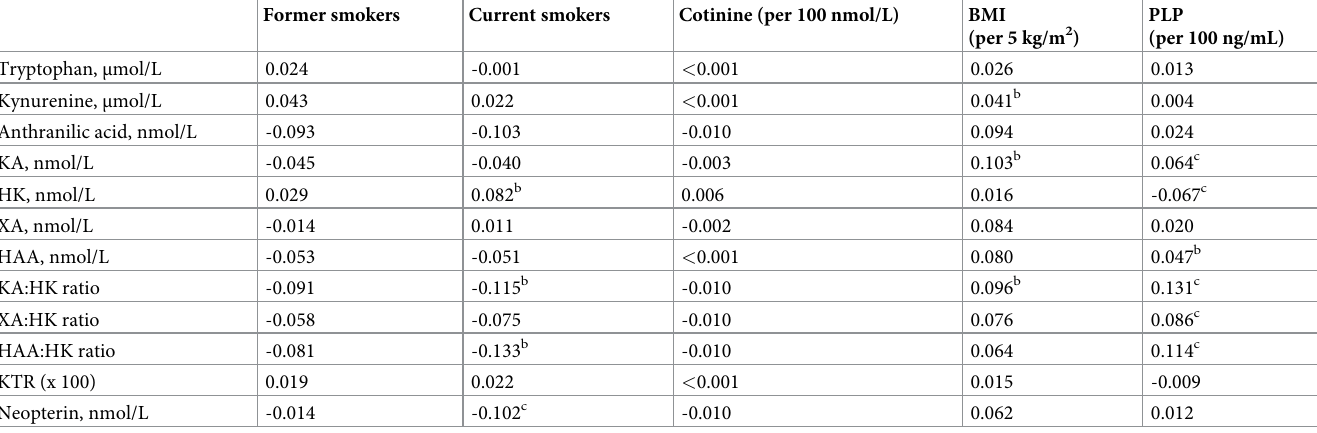
Table 3. Beta coefficients a for tryptophan and kynurenine metabolites derived from linear regression models on smoking status (current or former versus never smokers), cotinine, body mass index (BMI), and pyridoxal 5’-phosphate (PLP) among all controls (N =